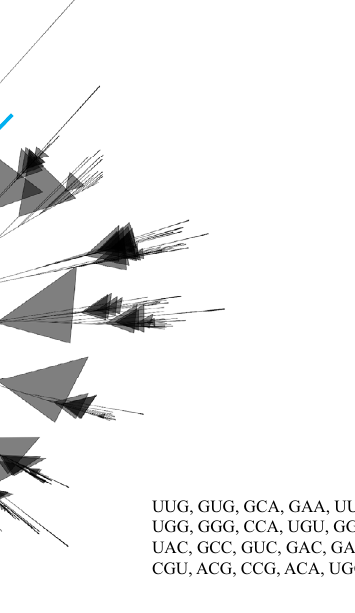
Figure 8. Phylogenetic tree of chloroplast tRNAs. The phylogenetic tree shows two distinct major clusters named clusters I and II. The phylogenetic tree shows that chloroplast tRNAs have evolved from multiple common ancestors. In cluster I, anticodons GCC, CGU, CGA, UCU, CAA, and UAG, are found in more than one group, and the anticodons GCC, GCU, UUC, CAU, and GAA are found in both clusters, showing